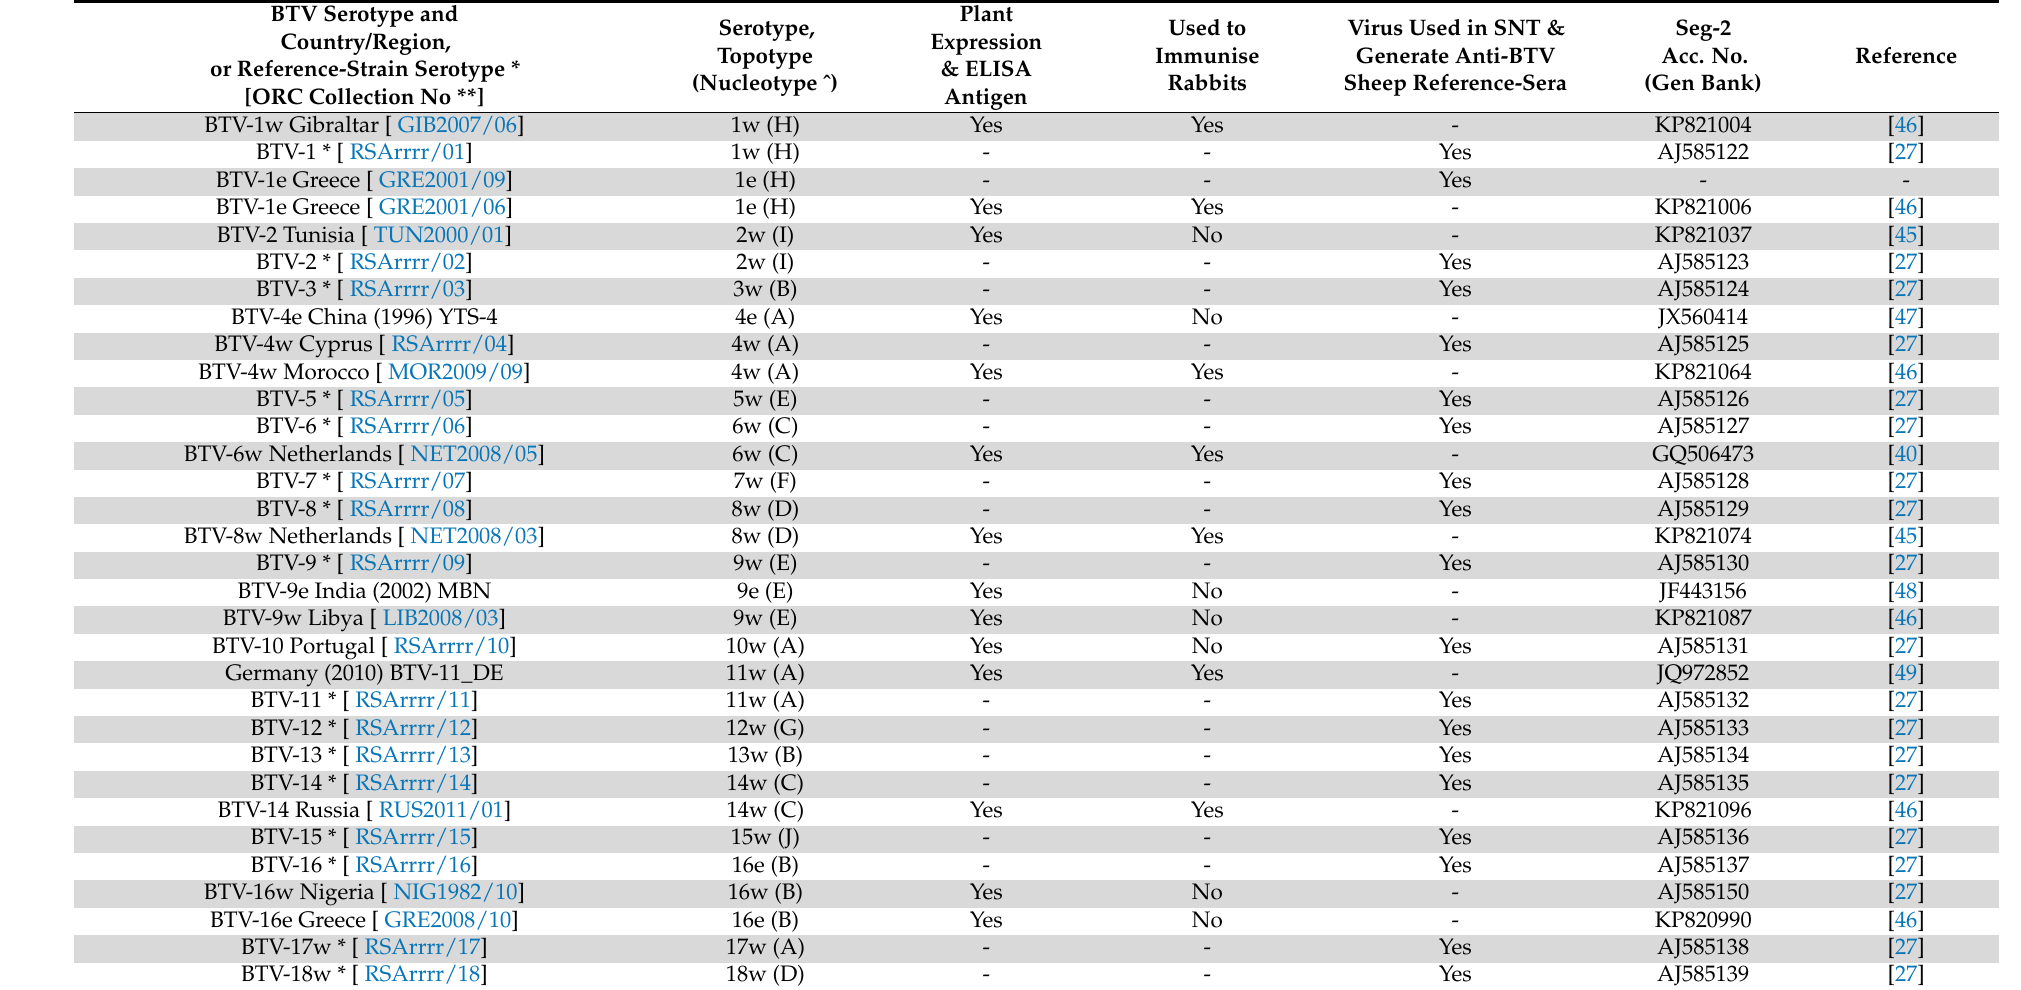
Table 1. BTV strains and VP2 sequences used for VP2 expression, SNT and phylogenetic